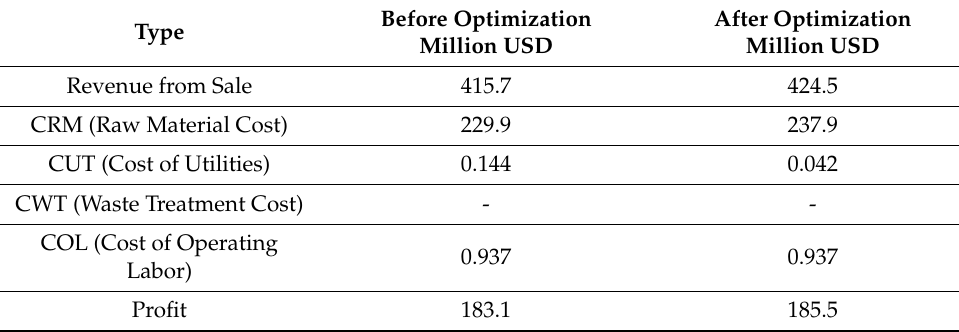
Table 13. Cost comparison before and after optimization of the Claus